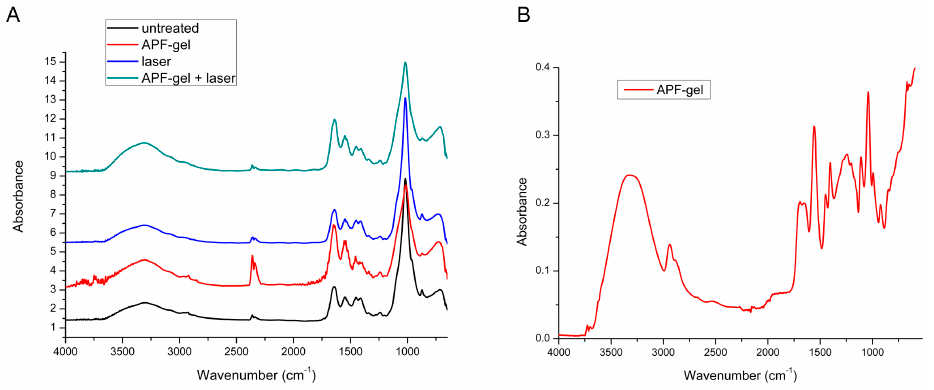
Figure 1. Means of infrared spectra in the range of 4000–650 cm − 1 : ( A )—obtained after treatments proposed for dentin, evidencing the differences in intensity of bands analyzed according to the treatments; ( B )—obtained from APF-gel used in this study.